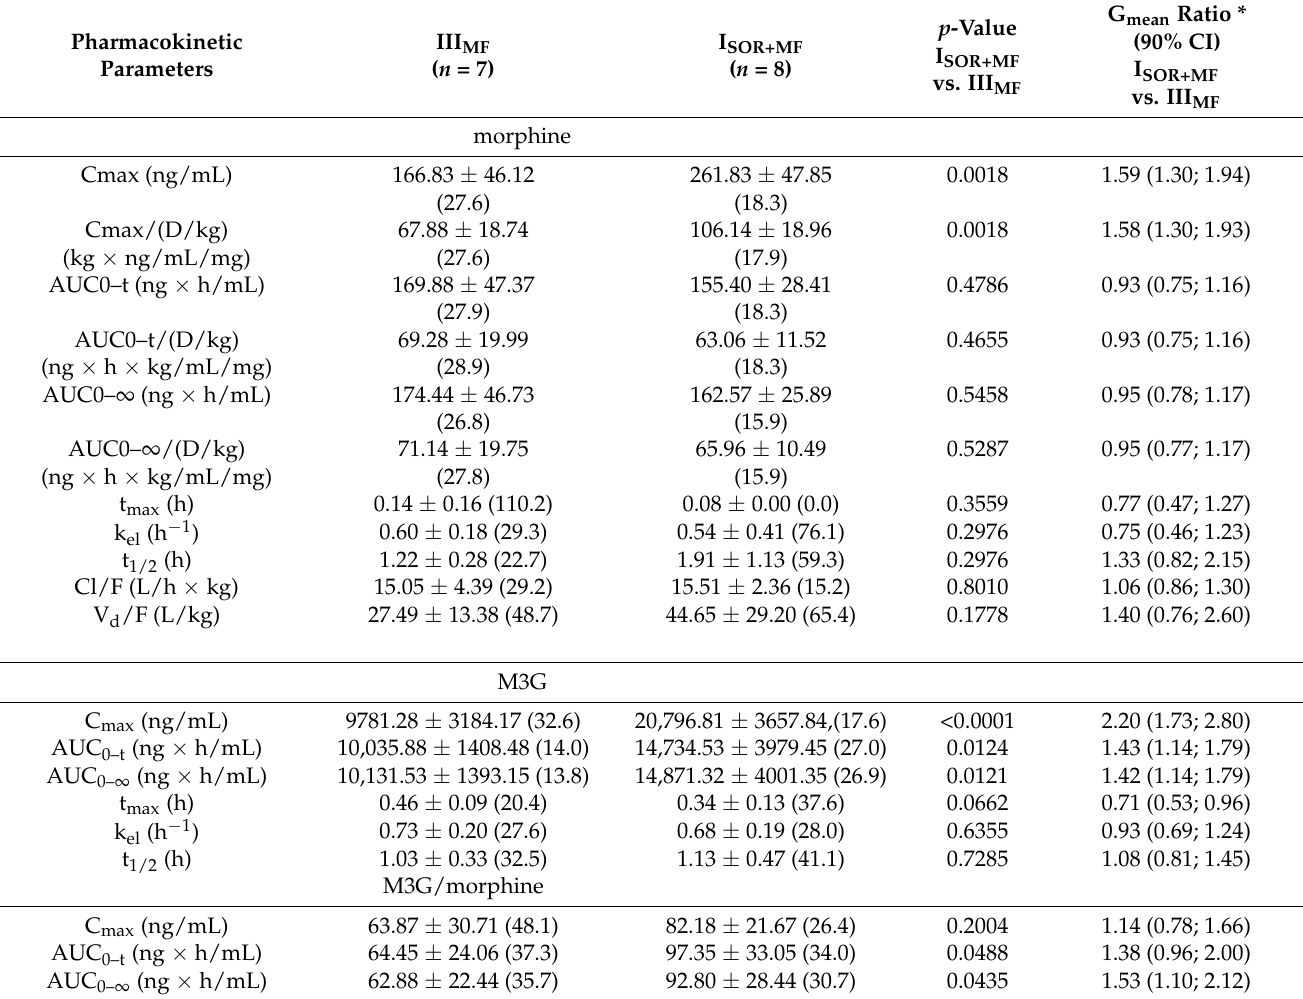
Table 2. Pharmacokinetic parameters of morphine and its metabolite M3G after a single intraperitoneal dose of 5 mg/kg b.w. of morphine (III MF group) and a single oral dose of 100 mg/kg b.w. of sorafenib + single intraperitoneal dose of 5 mg/kg b.w. of morphine (I SOR+MF